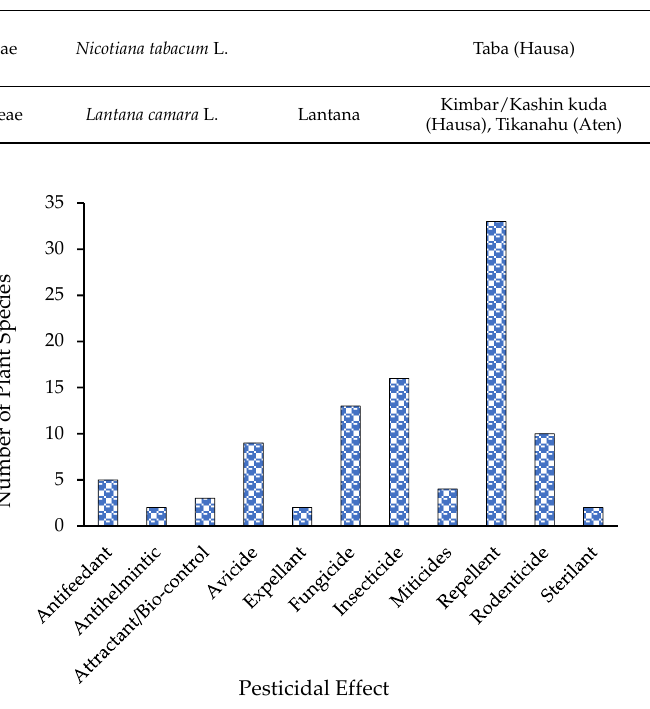
Figure 2. Number of plant species distributed for different pesticidal effects.